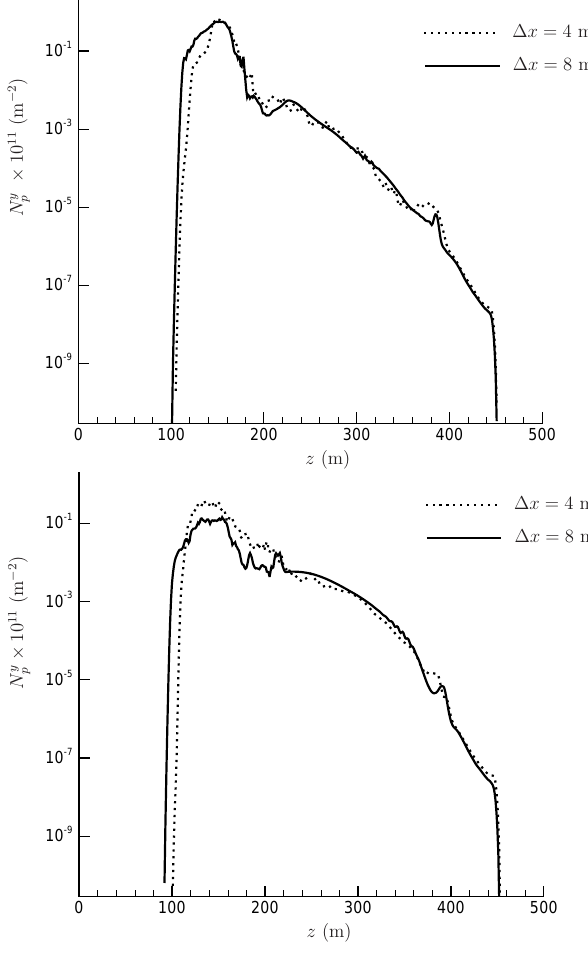
Fig. 7. Vertical profiles of particle number density N y p integrated in the transversal direction y at t = 140s for runs V 1 ( 1x = 4m) and V 3 ( 1x = 8m). Top panel: cut taken at x = 0 inside the vortex ring (location of maximum vortex spacing). Bottom panel: cut taken at x = 200m (location of minimum vortex